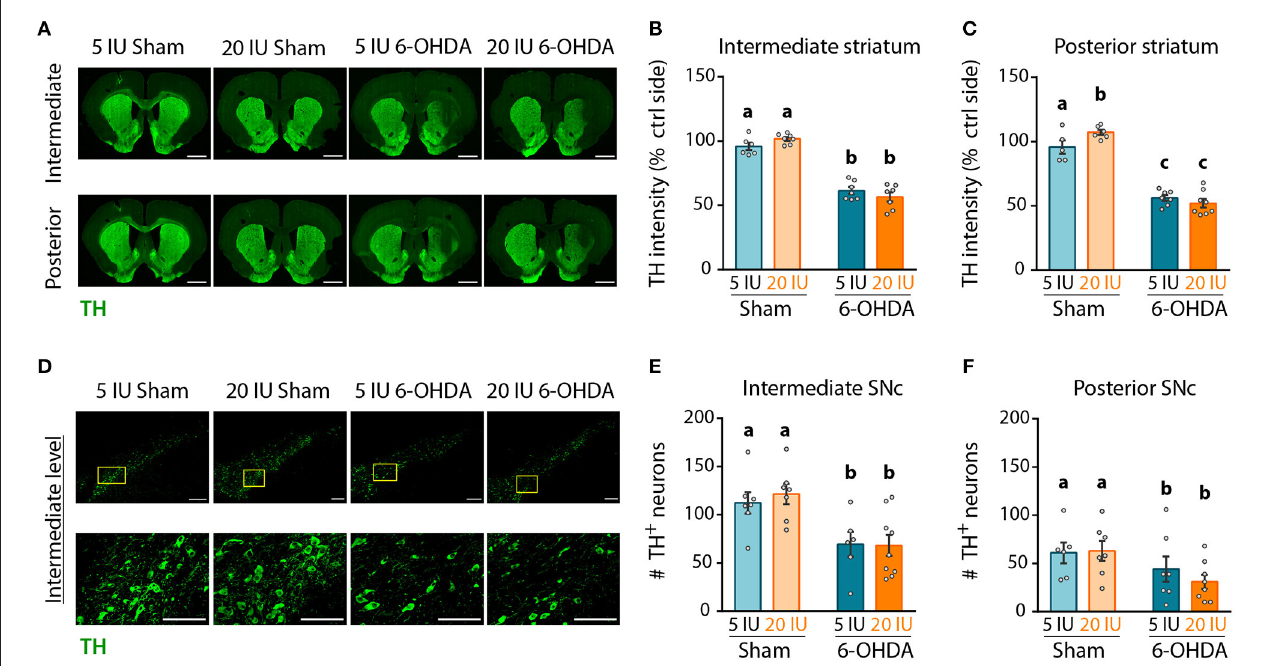
FIGURE 5 | Impact of 6-OHDA lesion and dietary vitamin A on extent of DA fibers in the striatum. (A) Representative images for the 4 experimental groups of intermediate and posterior striatum (lesioned and control sides) immunostained for tyrosine hydroxylase (TH) (green). Scale bar: 1000 µ m. (B,C) Quantification of fluorescence intensity of TH staining in intermediate (B) and posterior (C) striatum. TH intensity was normalized to the ipsilateral side. (D) Representative images for the 4 experimental groups of intermediate SNc (lesioned side) immunostained for TH (green). Top images correspond to a confocal mosaic of multiple images taken individually at 40X, scale bar: 200 µ m. Bottom images correspond to a zoom from mosaic images (yellow squares in top images), scale bar: 100 µ m. (E,F) Quantification of the number (#) of TH + neurons in intermediate (E) and posterior (F) SNc. Results are expressed as means ± SEM with individual data points. a–c: values significantly different ( p < 0.005). Details of the statistical analysis are summarized in Table 3